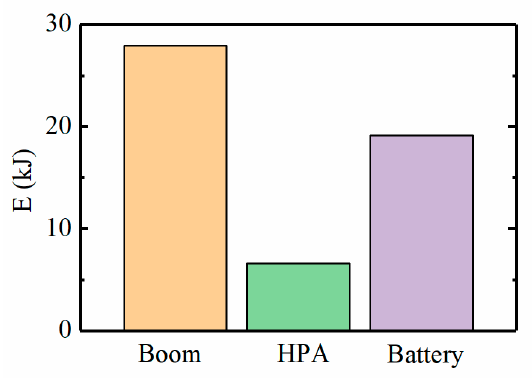
Figure 12. Distribution of the recovered energy during boom